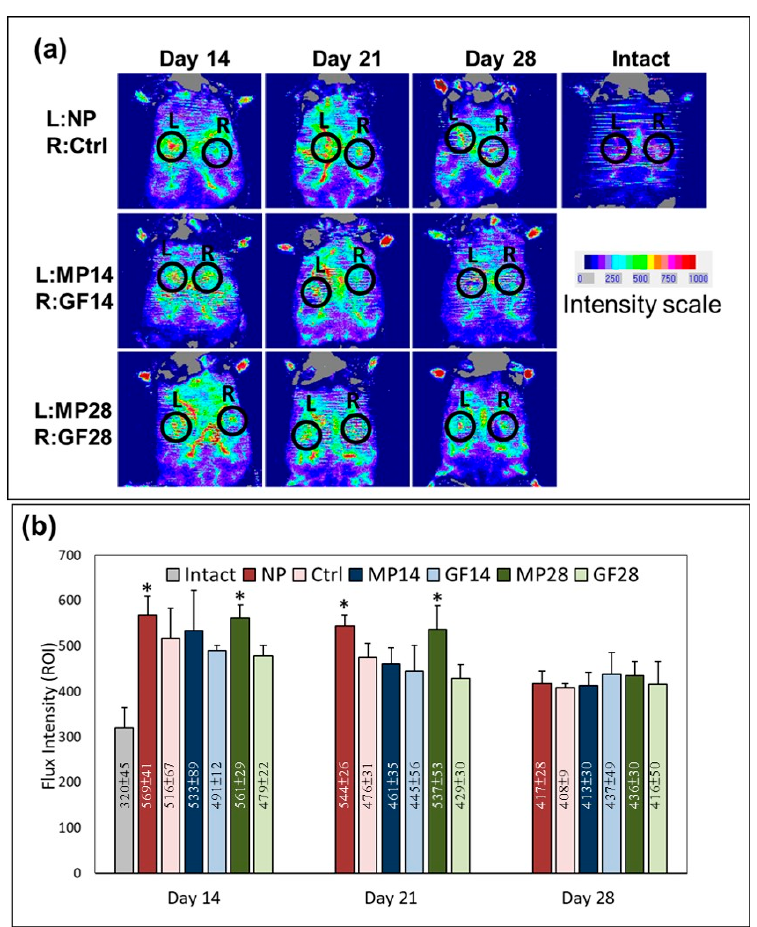
Figure 5. Assessment of blood flow at the wound as detected in laser Doppler scanning. ( a ) Repre- sentative blood flow images of GF14, MP14, GF28, MP28, control, and NP groups obtained on days 14, 21, and 28. Red and blue areas represent increased (normal) and reduced (or nonexistent) blood flow, respectively. ( b ) Quantitative data ( a ) showing blood flow in the ROI through flux intensity. Arbitrary units of flux intensity are expressed as the means ± SDs ( n = 8), with * p < 0.05 compared with the control group.